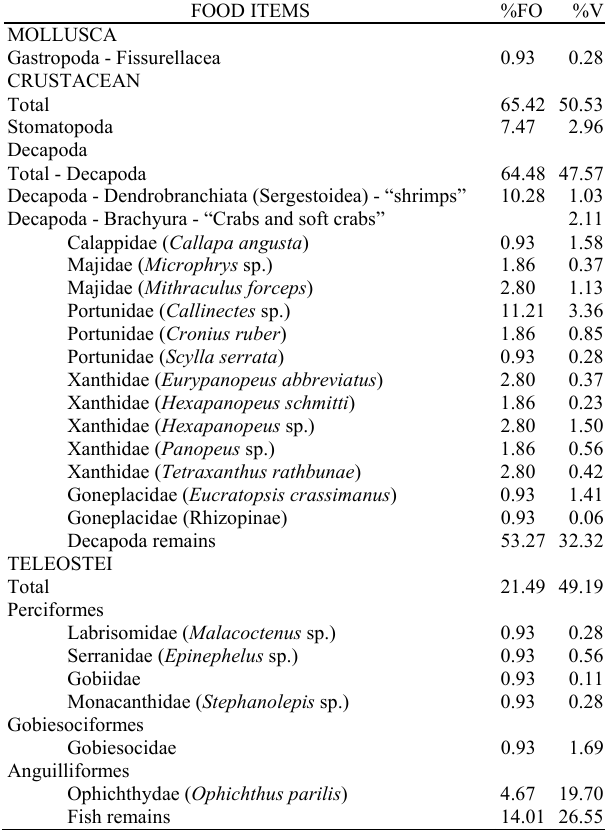
Table 1. Diet composition showing frequency of occurrence (% FO) and relative volume (V%) of the food items consumed by Lutjanus analis from Abrolhos Bank coral reefs, Eastern Brazil, between June 2005 and March